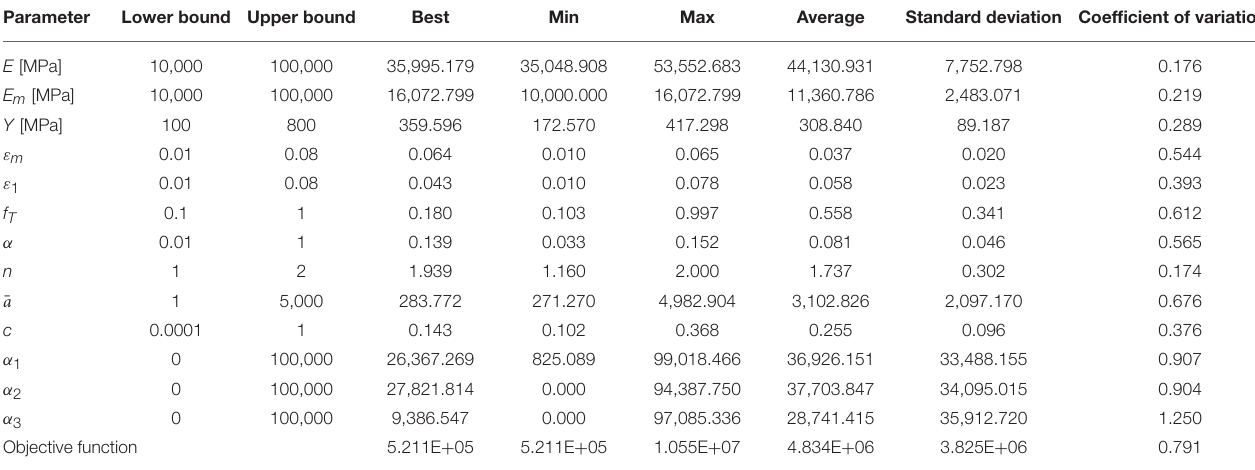
TABLE 6 | Statistical analysis of identification results for the Wilde-Gardoni-Fujino model with data obtained from Zhang and Zhu (2007). Parameter Lower bound Upper bound Average Standard deviation Coefficient of